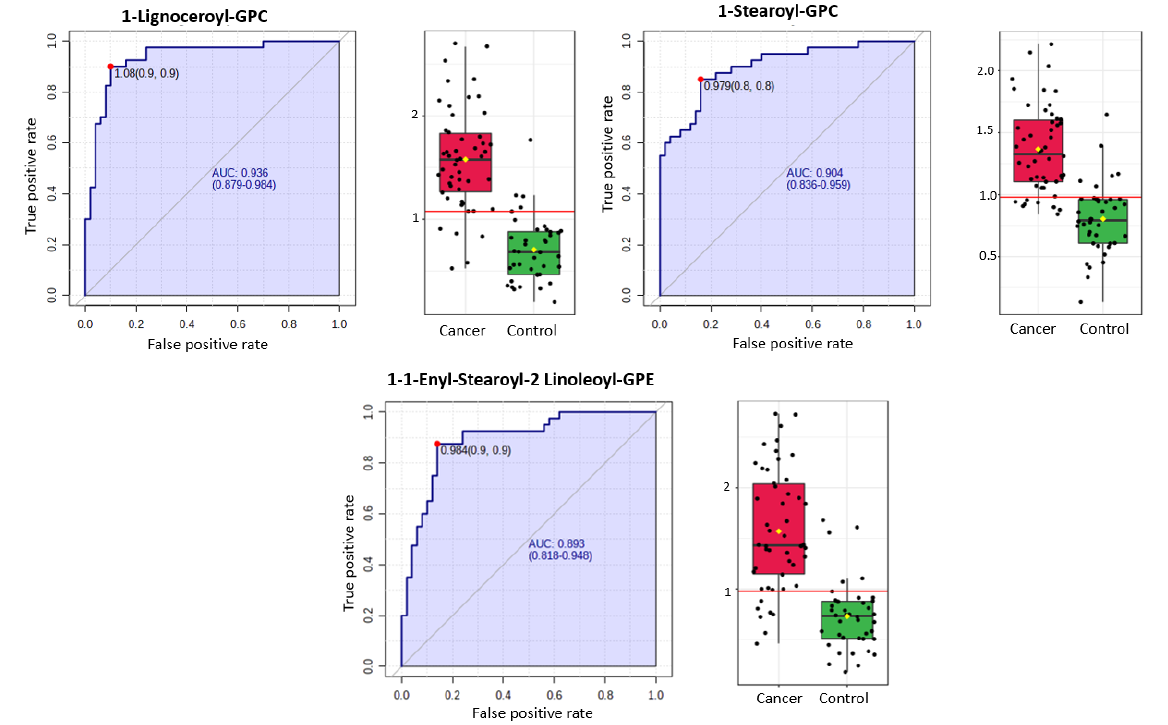
Figure 13. ROC curves of selected metabolites for endometrial cancer detection after exclusion of women with type 2 diabetes mellitus ( n = 90, cases = 50, controls = 40) based on AUC analysis. The optimal cut-off was based on the closest to the top left corner principle and is indicated by the red dot in the ROC curves.